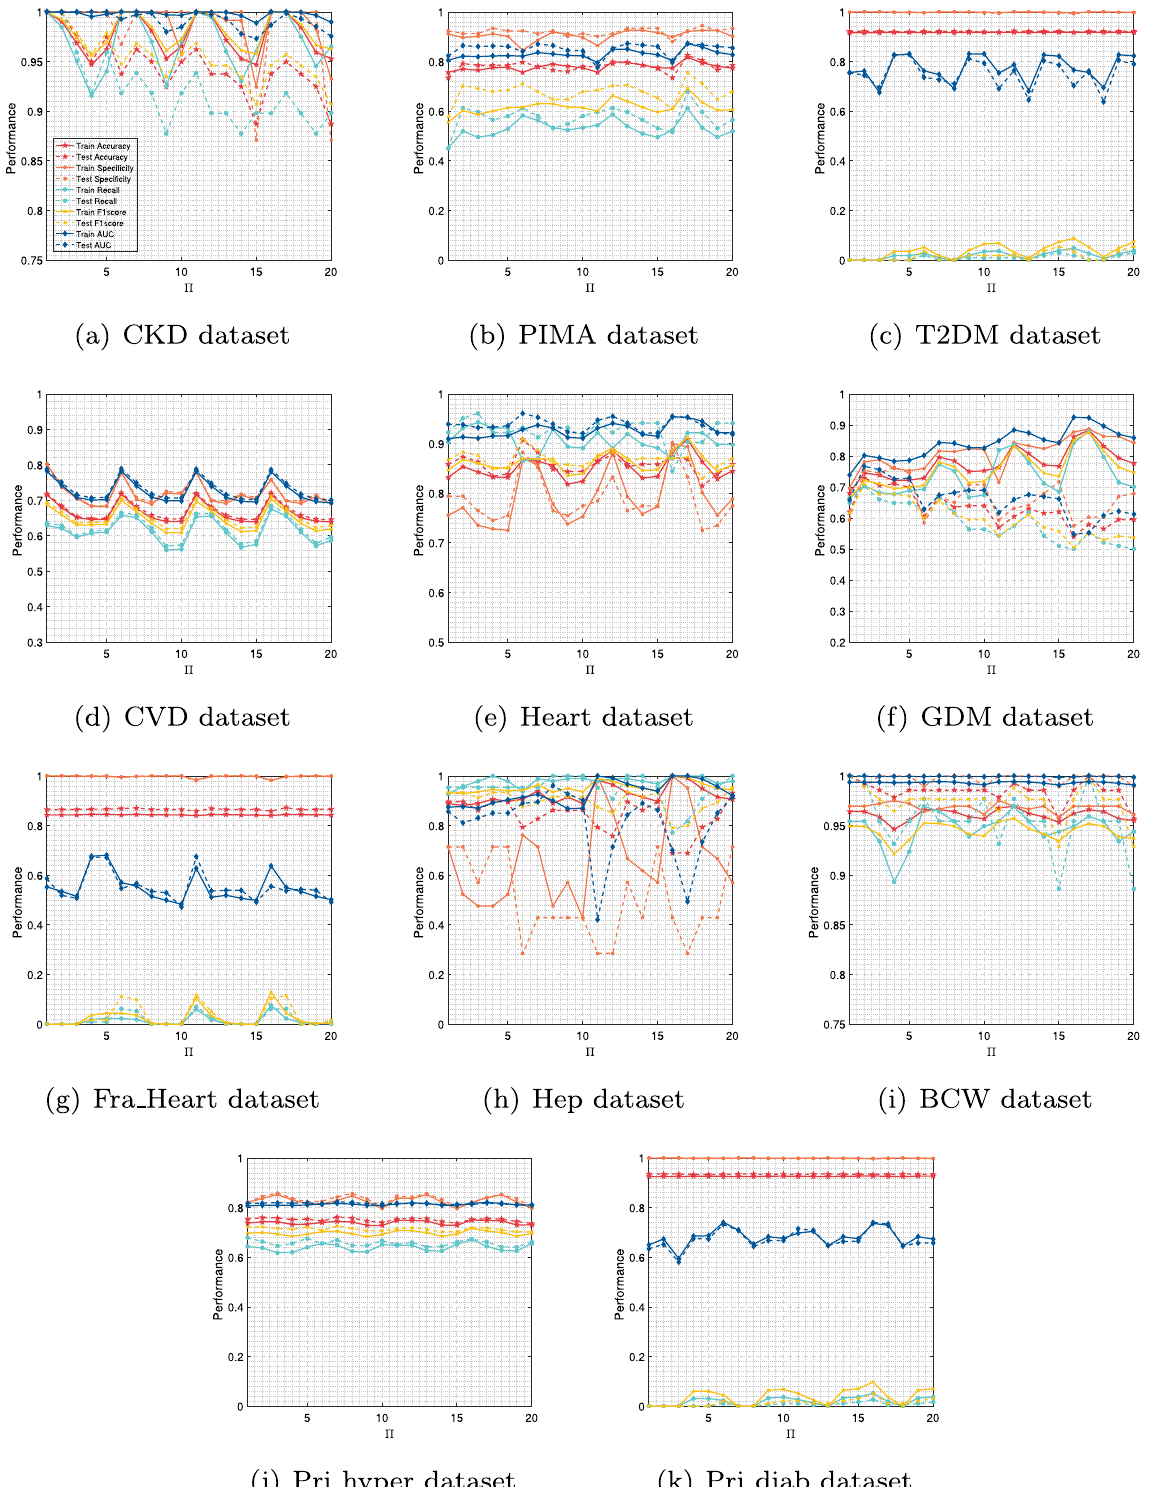
Figure 2. Training and test performance versus (� , (cid:31) ) on eleven chronic disease